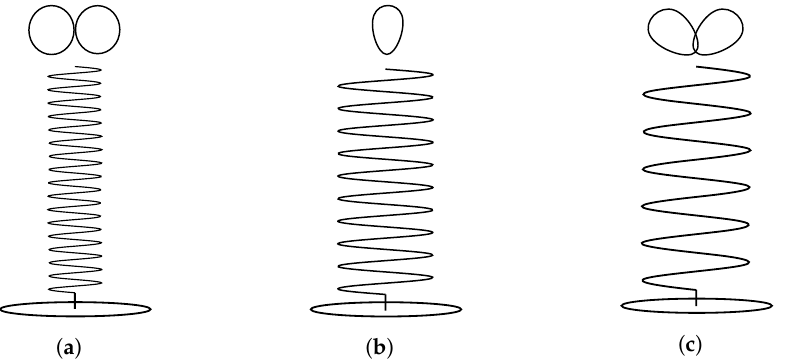
Figure 1. Overall geometry of helical antennas. ( a ) Geometry of helical antenna. ( b ) Unrolled turn of helical antenna.